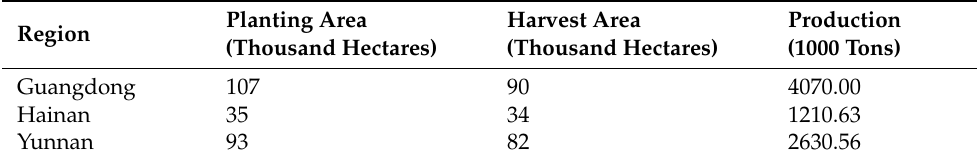
Table 1. Banana production of dominant regions in China (2018).